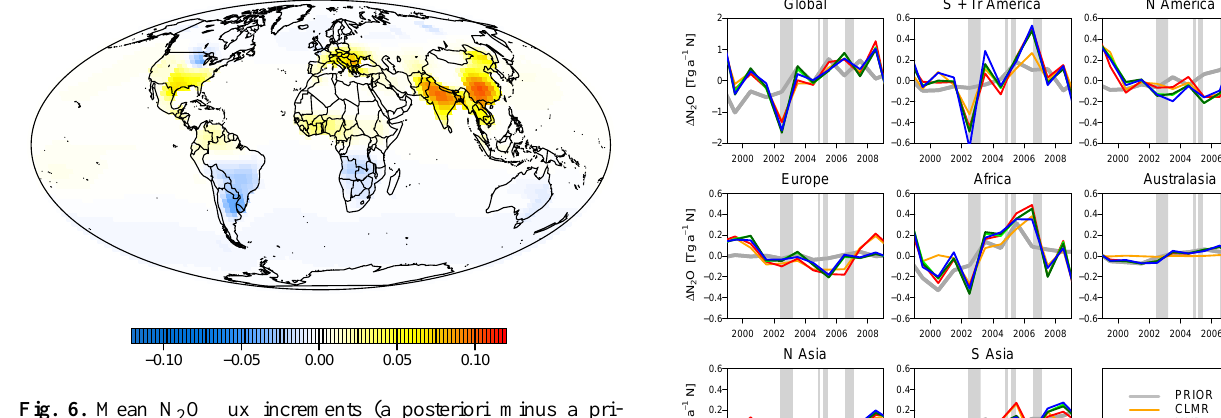
//www.esrl.noaa.gov/psd/enso/mei/) value above 0.6, i.e.